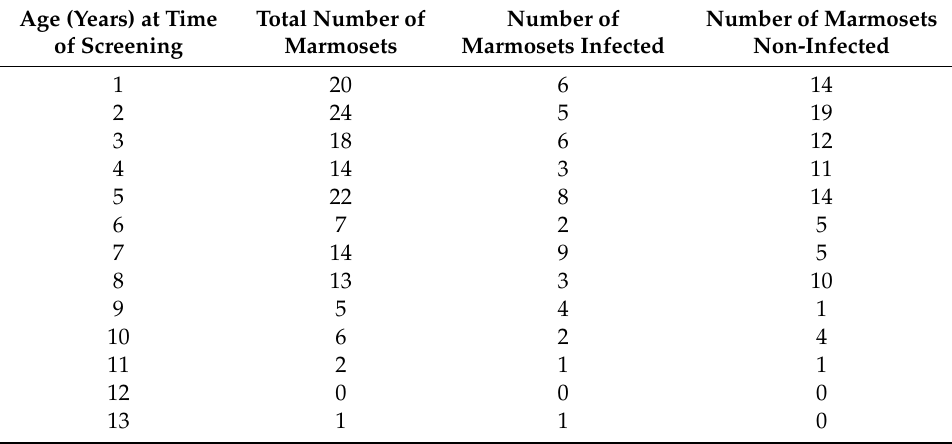
Table 1. SOBV status by age of 146 common marmosets at the